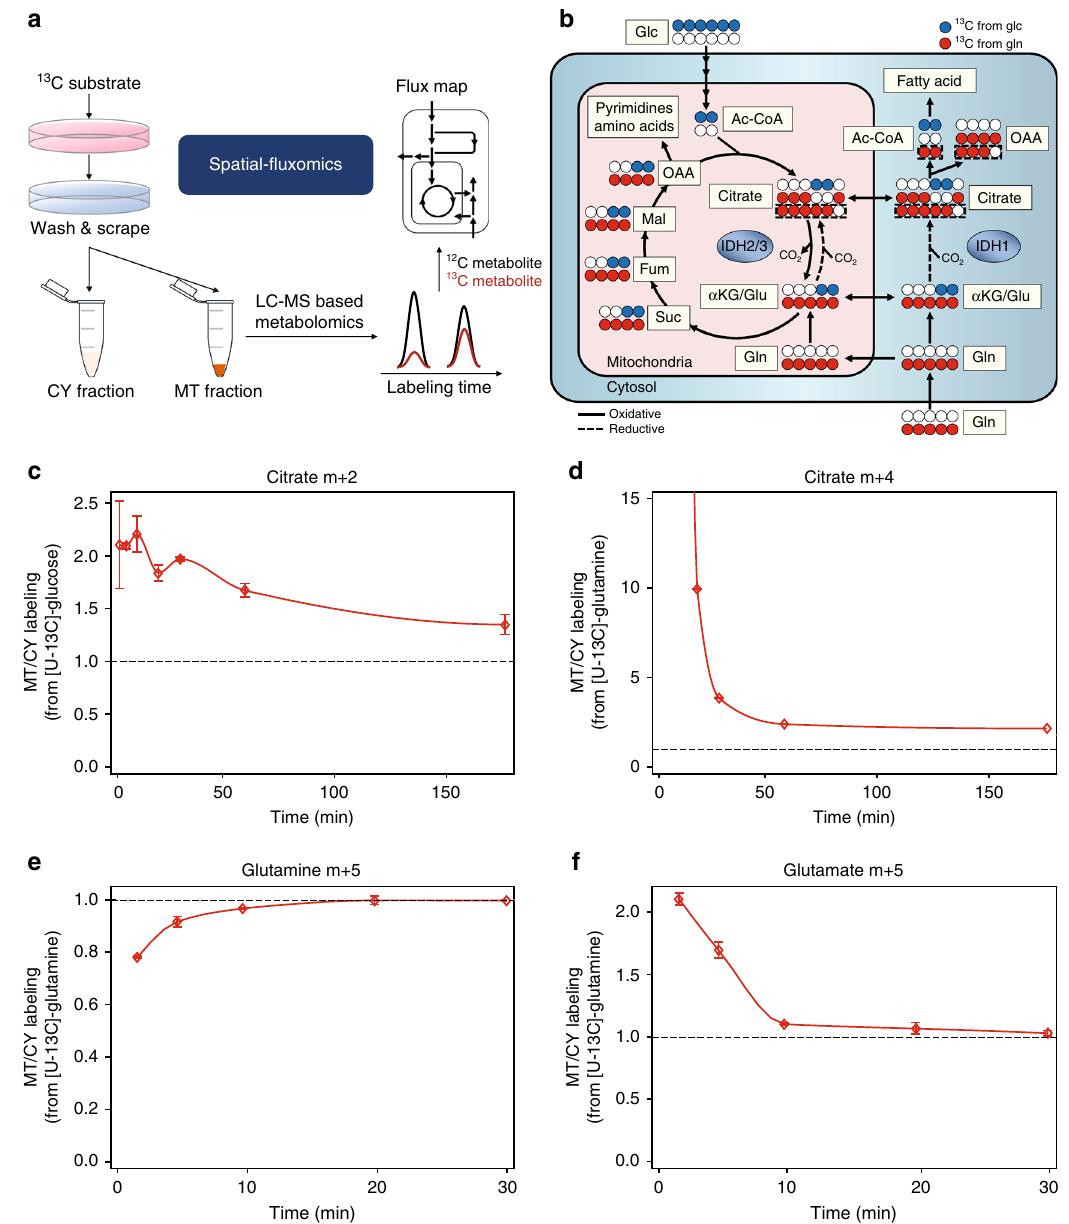
Fig. 2 Compartment-speci fi c isotope tracing in mitochondria and cytosol. a A schematic description of the spatial- fl uxomics approach. b TCA cycle metabolism and associated reactions involving acetyl-CoA and fatty acid metabolism. c Isotopic labeling kinetics of citrate m + 2 in mitochondria versus cytosol when feeding HeLa cells with [U- 13 C]-glucose; showing the ratio between the relative abundance of the m + 2 form of citrate in the mitochondria (out of the entire mitochondrial pool) divided by the relative abundance of citrate m + 2 in cytosol. d – f The isotopic labeling kinetics of citrate m + 4 ( d ), glutamine m + 5 ( e ), and glutamate m + 5 ( f ) when feeding [U- 13 C]-glutamine. Data are mean ± SD, n = 3 independent biological